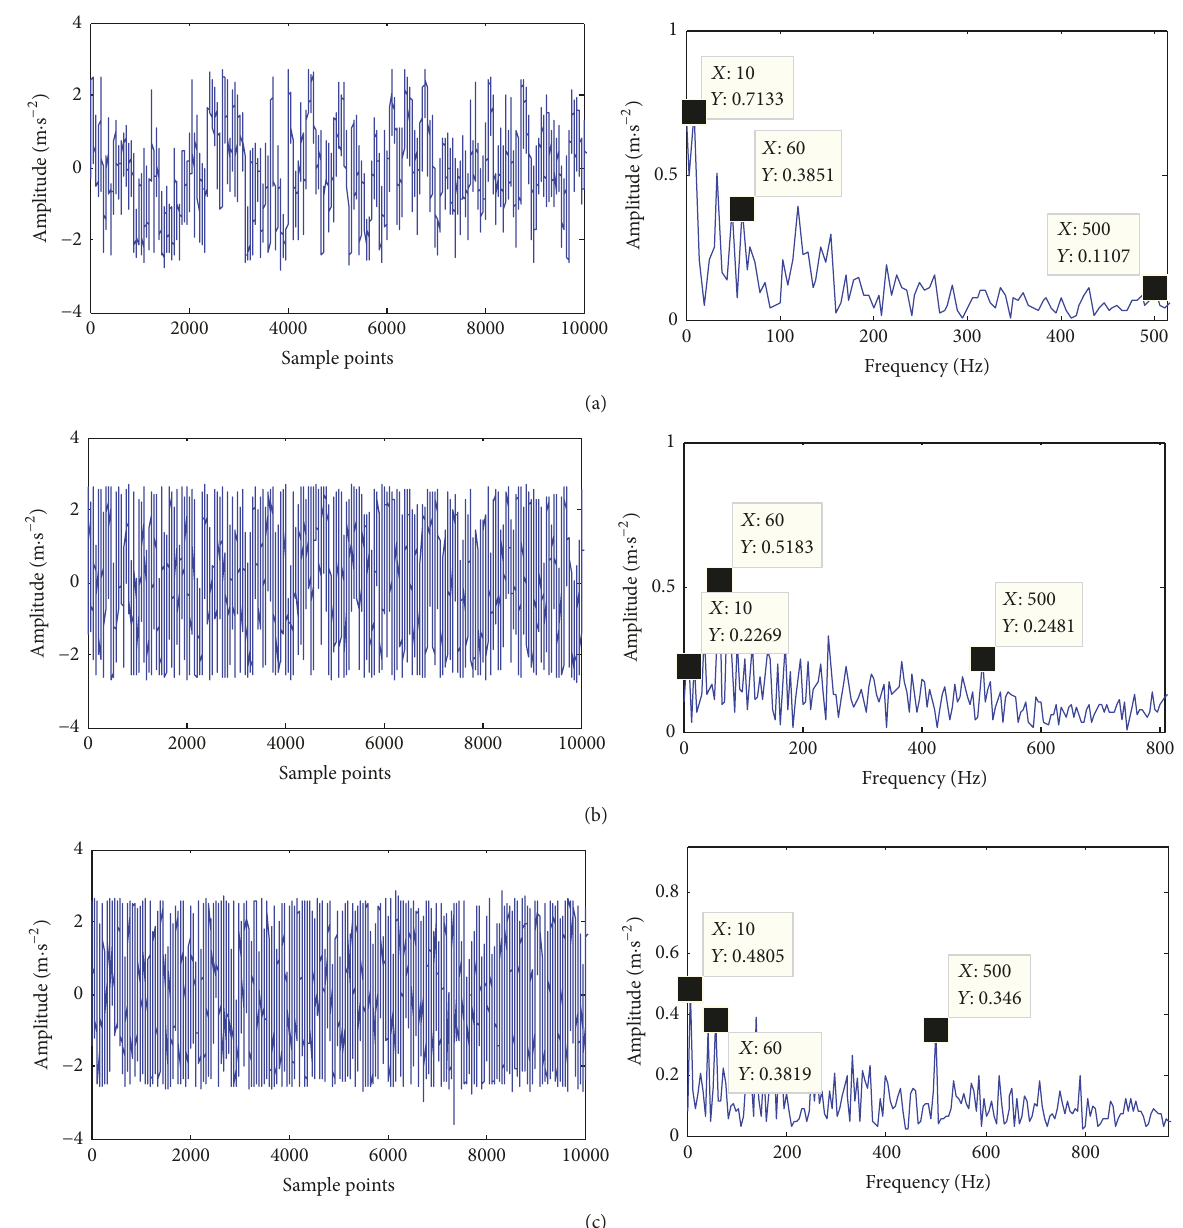
Figure 10: The time domain and spectrum of output signal through the rescaling multistable